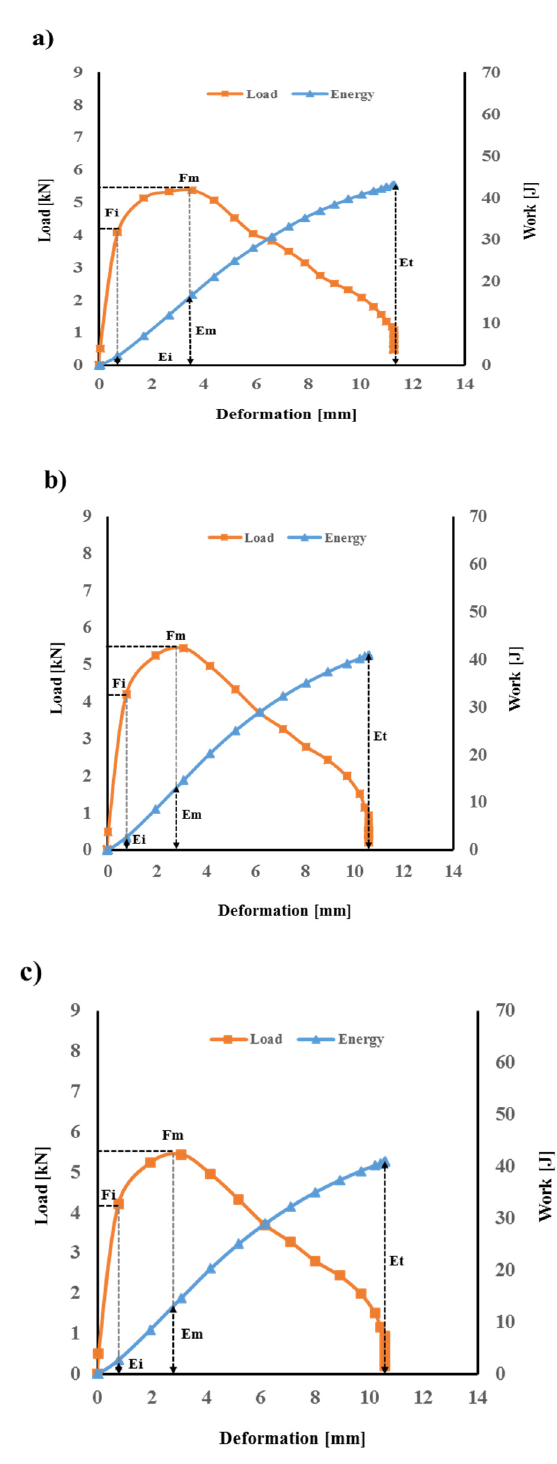
Figure 5. Load and work vs. deformation for flax / VE composites: ( a ) flax 50 J, ( b ) flax 60 J, and ( c ) flax 70 J. FM, load maximum; FI, incipient damage load; EM, energy maximum; EI, incipient damage energy; ET, energy total.